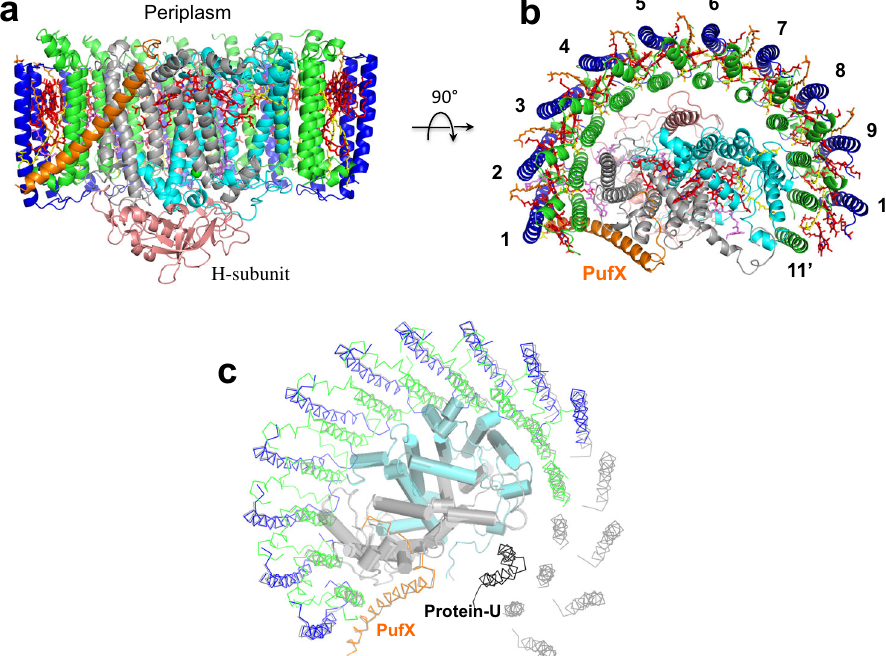
Fig. 6 Structure of the Rba . sphaeroides LH1 – RC Δ U monomer. a Side view of the complex with PufX (orange) in the front. Color scheme is the same as in Fig. 1. b Top view from periplasmic side of the membrane with numbering for the LH1 polypeptides. c Overlap view of the Δ U monomer (colored) and wild- type monomeric Rba. sphaeroides LH1 – RC (gray, PDB: 7F0L) by superposition of C α carbons of the RC M-subunits. Protein-U as it exists in the wild-type monomer is shown by a black ribbon.